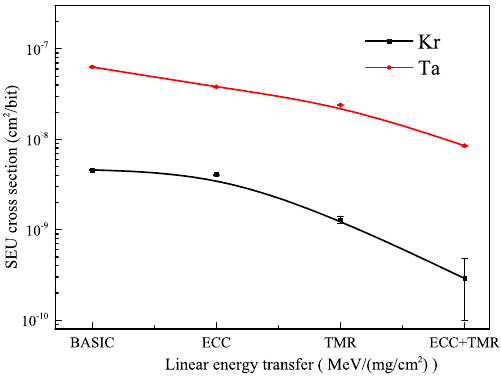
Figure 9. SEU cross section in four kinds of configured EBRAM vs.